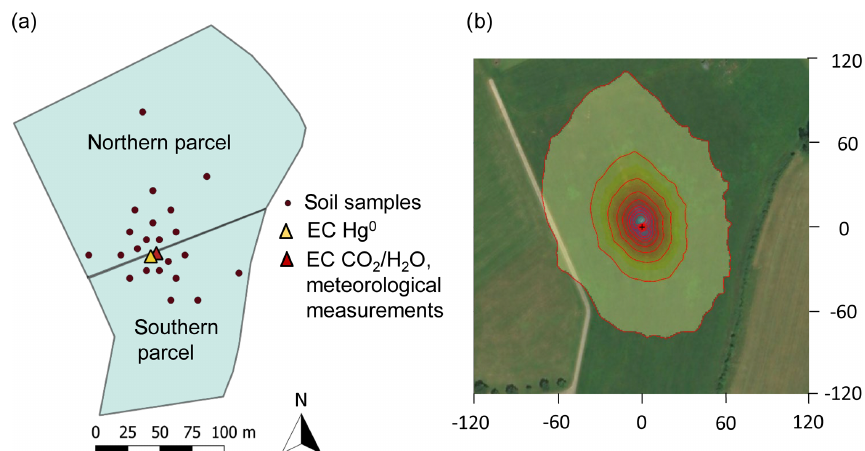
Figure 1. (a) Schematic of the experimental setup at the Chamau (CH-Cha) research site showing the exact locations of topsoil samples for total Hg analysis ( n = 22) and eddy covariance (EC) flux measurements of Hg 0 , CO 2 and H 2 O conducted between 20 July and 6 Septem- ber 2018. Panel (b) shows the footprint contour lines of 10% to 90% in 10% steps representing the flux source area during our measurement period. Numbers indicate the distance in meters from the EC station (black cross). The footprint was calculated by applying the footprint model presented in Kljun et al. (2015). Figure (b) is a direct output from the following online tool: http://footprint.kljun.net/ (last access: 6 February